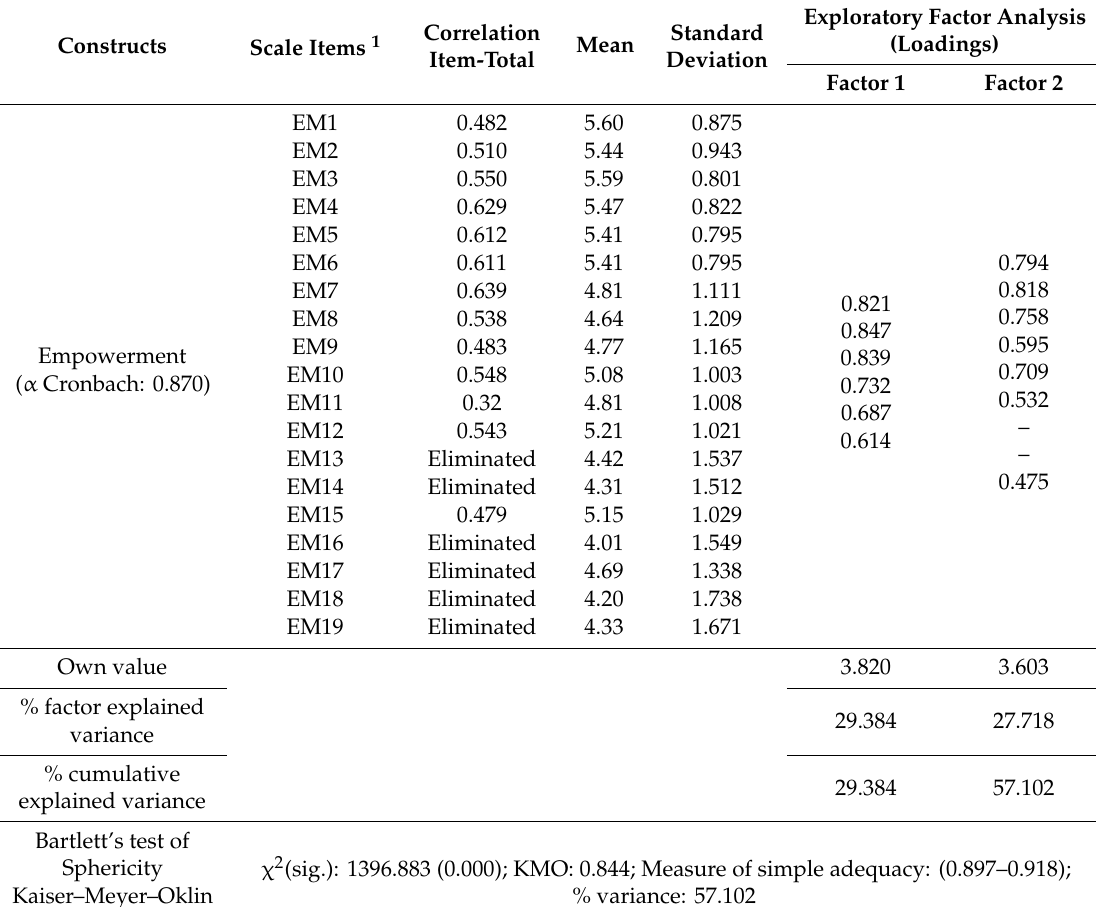
Table 2. Descriptive Findings and Exploratory Factor Analysis (Reliability and Validity of